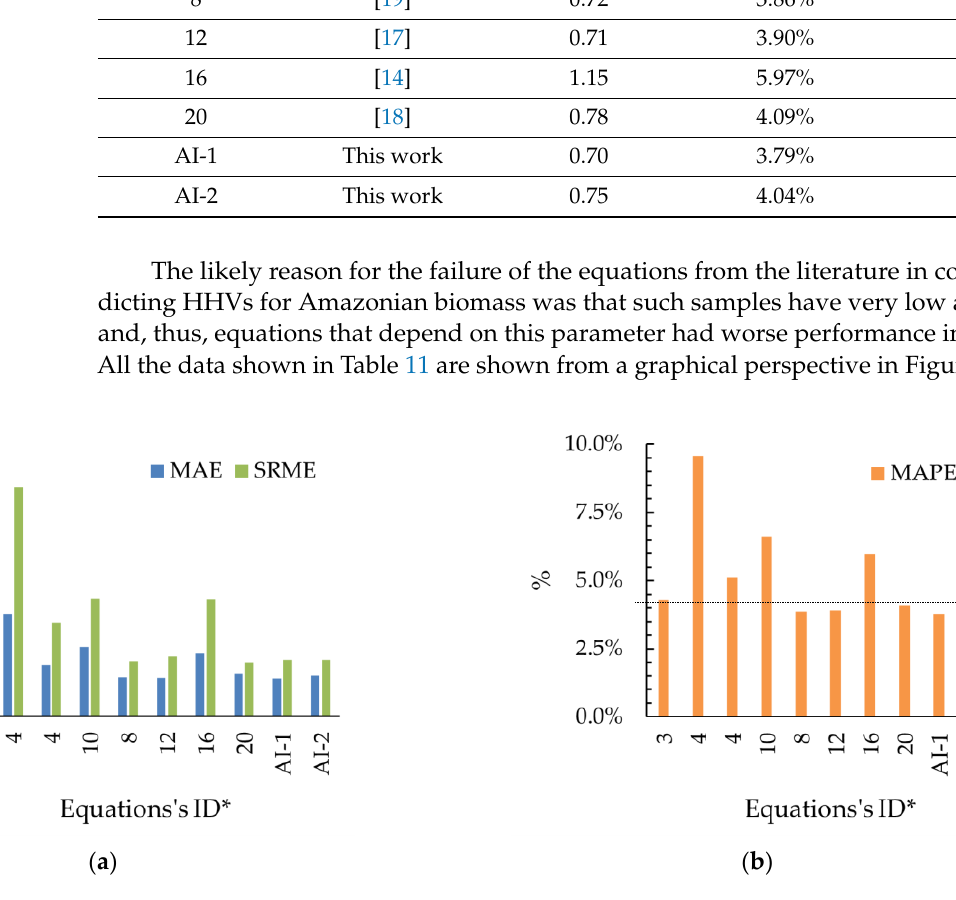
Figure 9. Graphs with the main error analyses for HHV predictions from equations based on the proximate analysis: ( a ) mean absolute error (MAE) and square root mean error (SRME); ( b ) mean absolute percentage error (MAPE). * ID: equation identification.